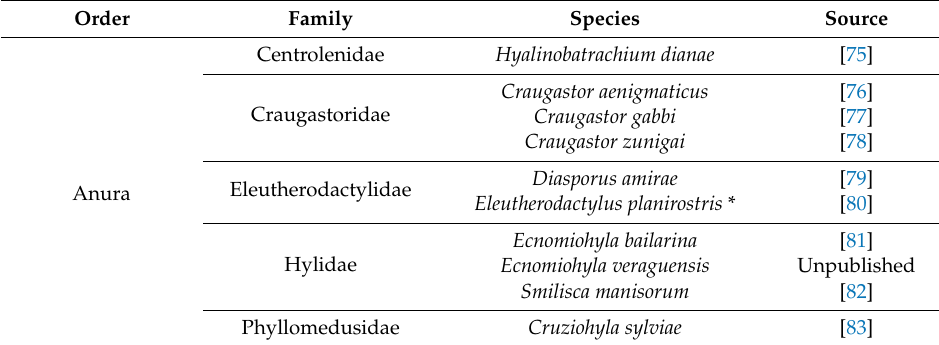
Table 3. List of new additions to the updated list of amphibians of Costa